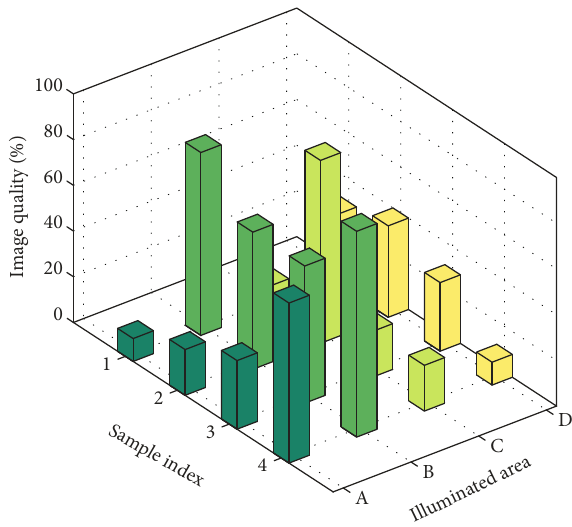
Figure 4: Three-dimensional histogram of image quality in di ff erent illumination